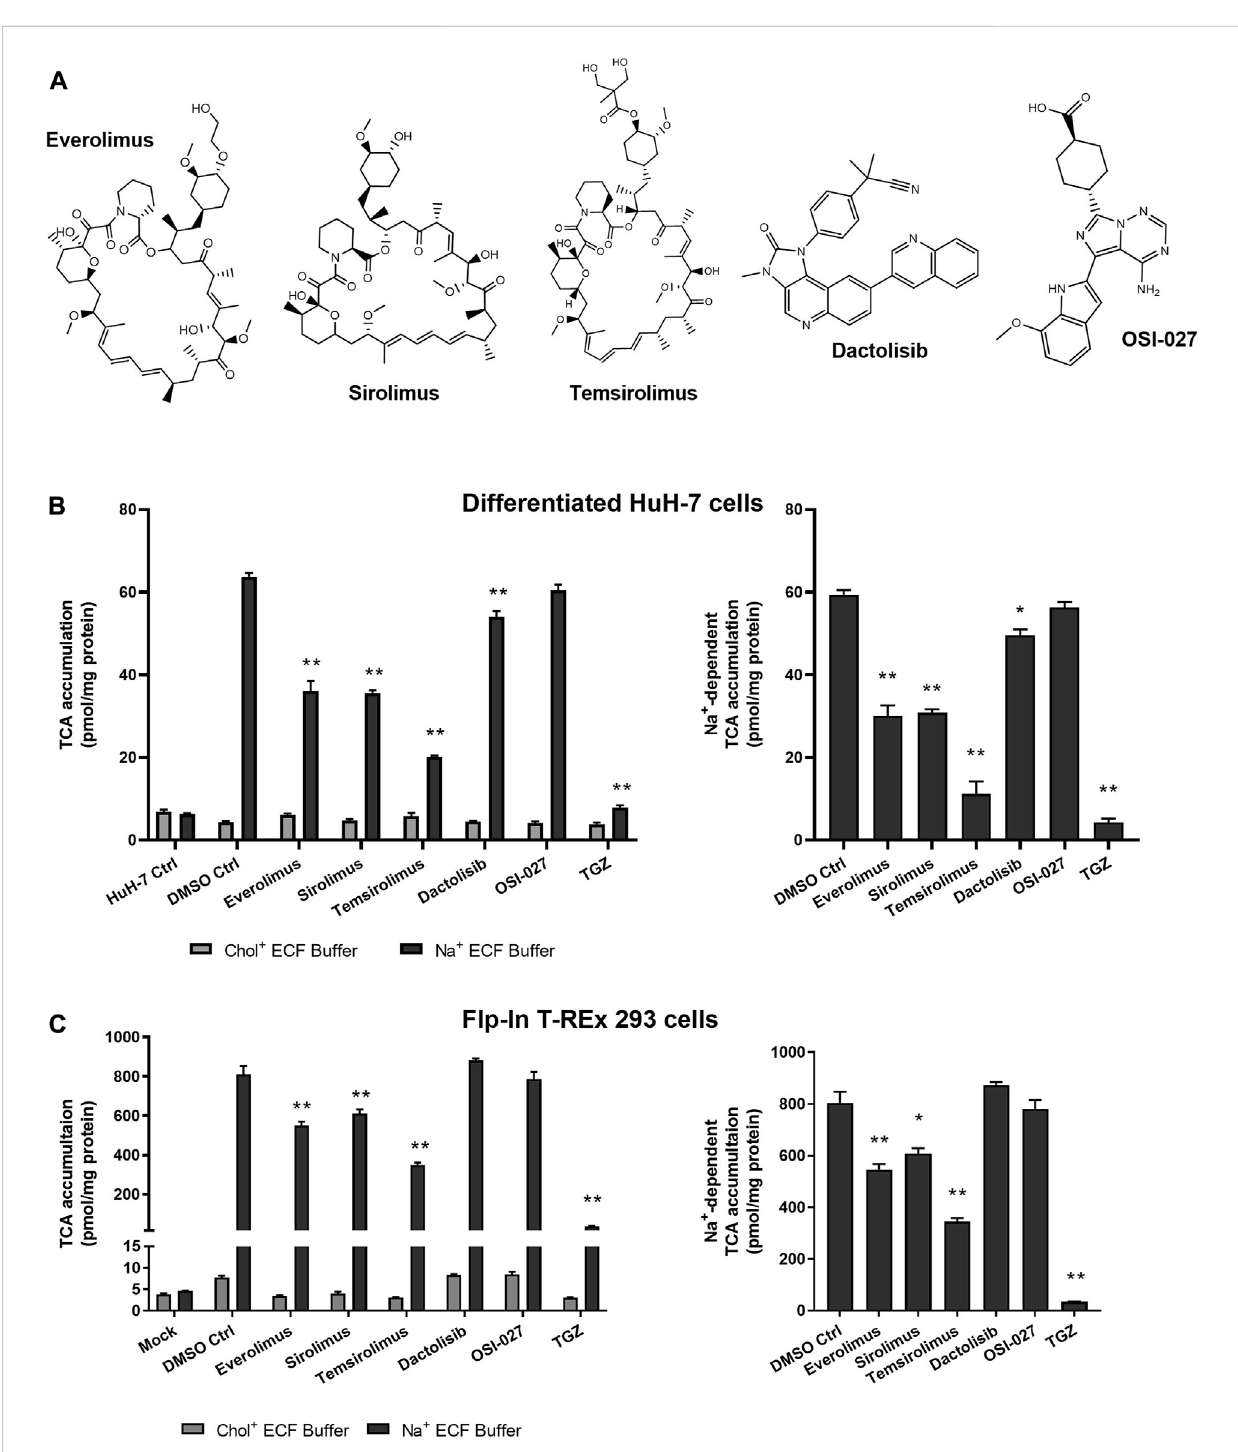
Effect ofstructuraland functional analogs ofeverolimus on NTCP-mediatedtaurocholate (TCA)transport. (A) Structuresof themTOR inhibitors tested. Accumulationof[ 3 H]-TCA(2 μ M;200 nCi/mL)inextracellular fl uidbuffer(ECF)withNa + orwithoutNa + (Chol + )over10 minwasmeasuredinthepresenceof 0.1% DMSO control (DMSO Ctrl) or mTOR inhibiting drugs (10 µM) in (B) undifferentiated (HuH-7 Ctrl) and differentiated HuH-7 cells, or (C) Mock-GFP and NTCP-GFP-expressingFlp-In ™ T-REx ™ 293cells.Mock-GFPorNTCP-GFPwereinducedinFlp-In ™ T-REx ™ 293cellswith1 μ g/mLdoxycyclineforthree days. All cells were pretreatedfor 15 min with 0.1% DMSO or drugs (10 µM) in cell culture medium prior to initiation of the accumulation phase. Troglitazone (TGZ; 75 μ M), a known inhibitor of NTCP, was used as a positive control. (B) and (C) Left panels: Statistically signi fi cant differences compared to DMSO Ctrl were measured using an ordinary two-way ANOVA with Dunnett ’ s multiple comparison test (*, p < 0.05, **, p < 0.0001). (B) and (C) Right panels: Na + - dependent [ 3 H]-TCA accumulation was calculated by subtracting [ 3 H]-TCA accumulation in Chol + buffer from [ 3 H]-TCA accumulation in Na + buffer. Statisticallysigni fi cantdifferencescomparedtoDMSOCtrlweremeasuredusinganordinaryone-wayANOVAwithDunnett ’ smultiplecomparisontest(*, p < 0.05, **, p < 0.0001). All data were plotted as mean ± SD ( n =